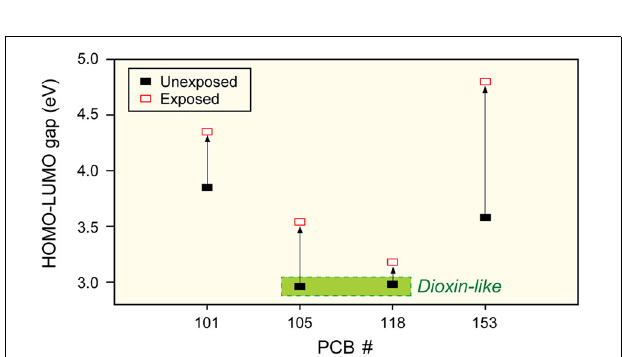
FIGURE 5 | XES and XAS measurements. (A) Superposition of XES and XAS measurements of PCB-118 (exposed) (B) 2nd Derivative Method to determine HOMO-LUMO gap. HOMO-LUMO gap is determined by difference between π and π ∗ energies, in this case 3.178eV.